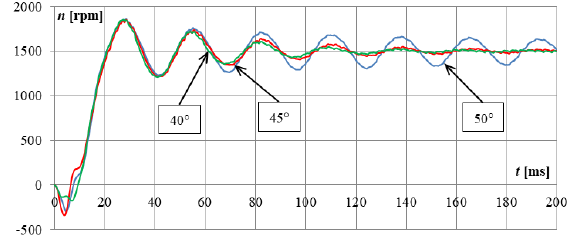
Fig. 4. Waveforms n ( t ) for W1 rotor;  = const and h = 5 mm .